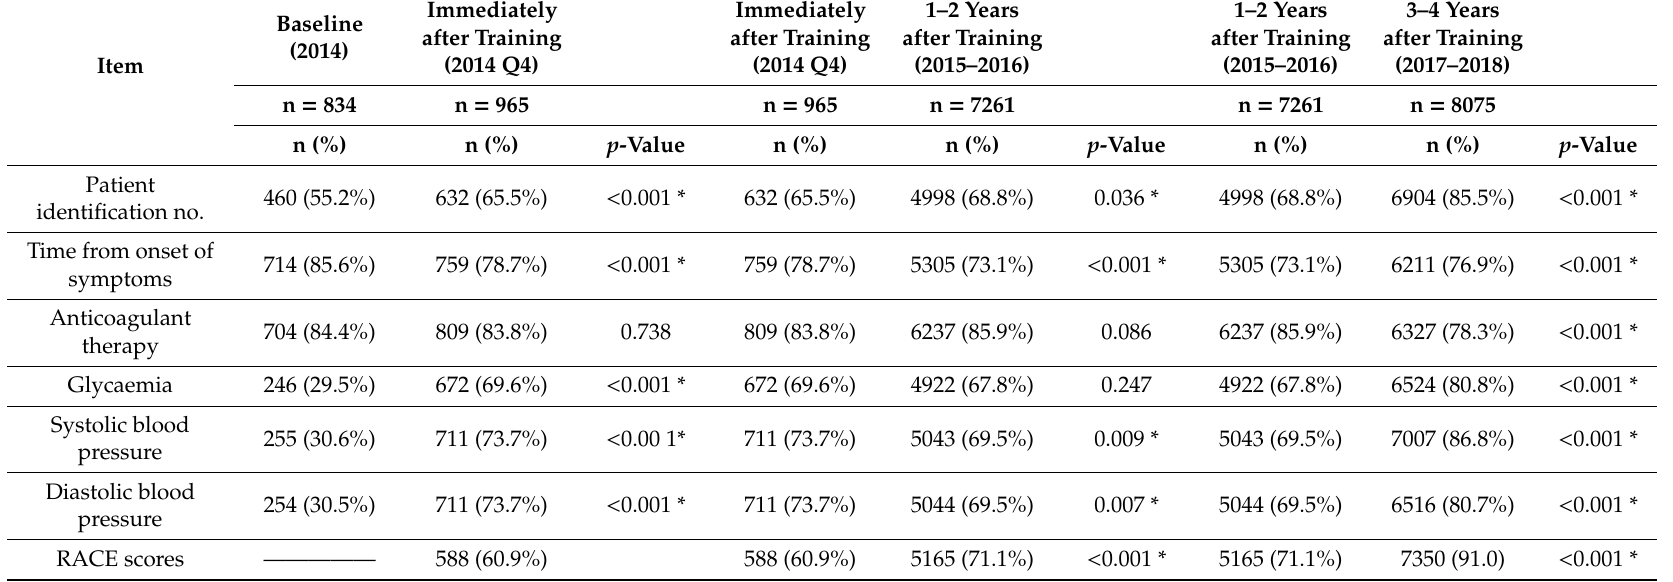
Table 2. Di ff erences in the pre-notification items from the Minimum Data Set register over